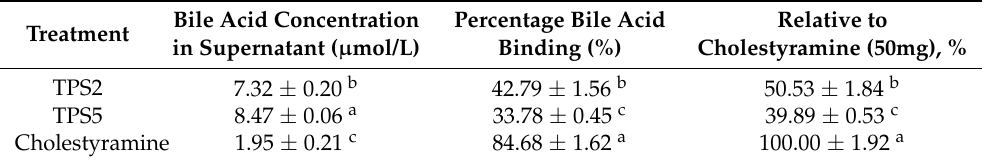
Percentage Bile